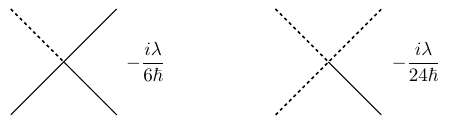
Figure 10 . Feynman diagrams for the interactions, with the solid line representing (cid:30) cl , and the dashed line corresponding (cid:30) q